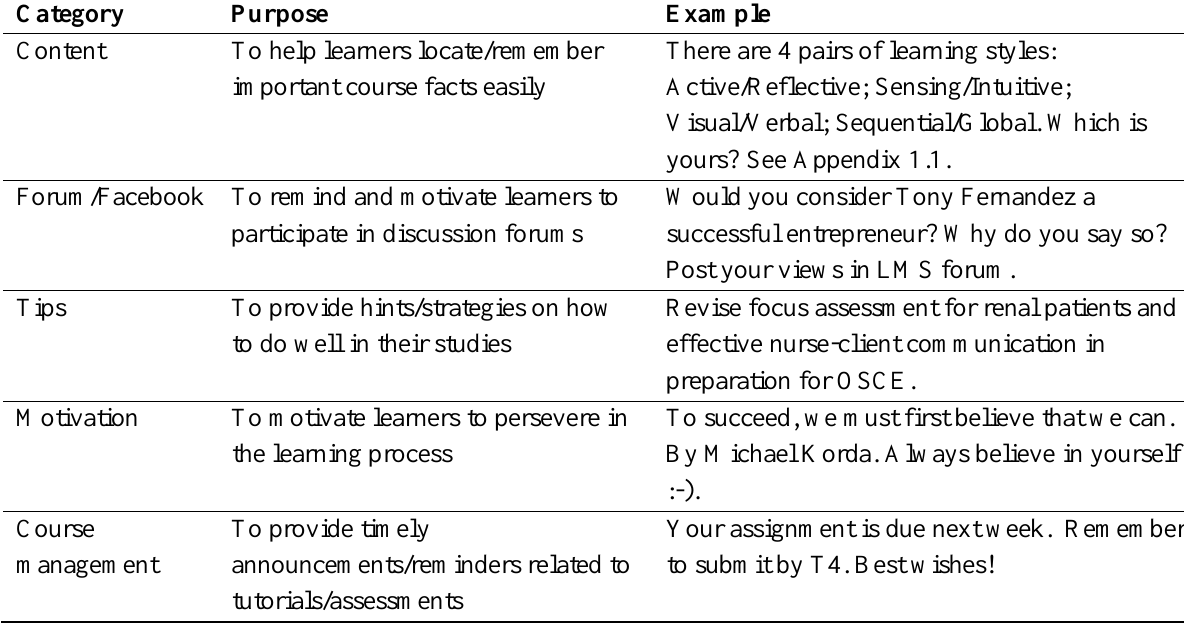
Table 1 SMS Categories, Purpose, and Examples Category Content